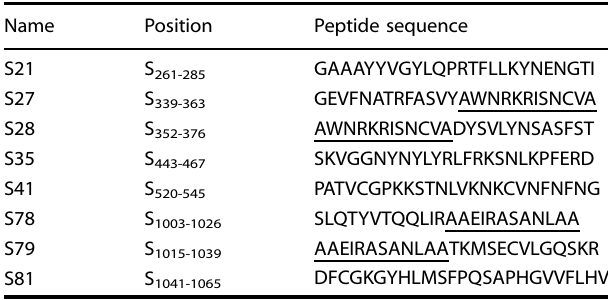
Underline indicated overlapping region in adjacent peptides (S27/S28 or S78/S79) containing potential T cell